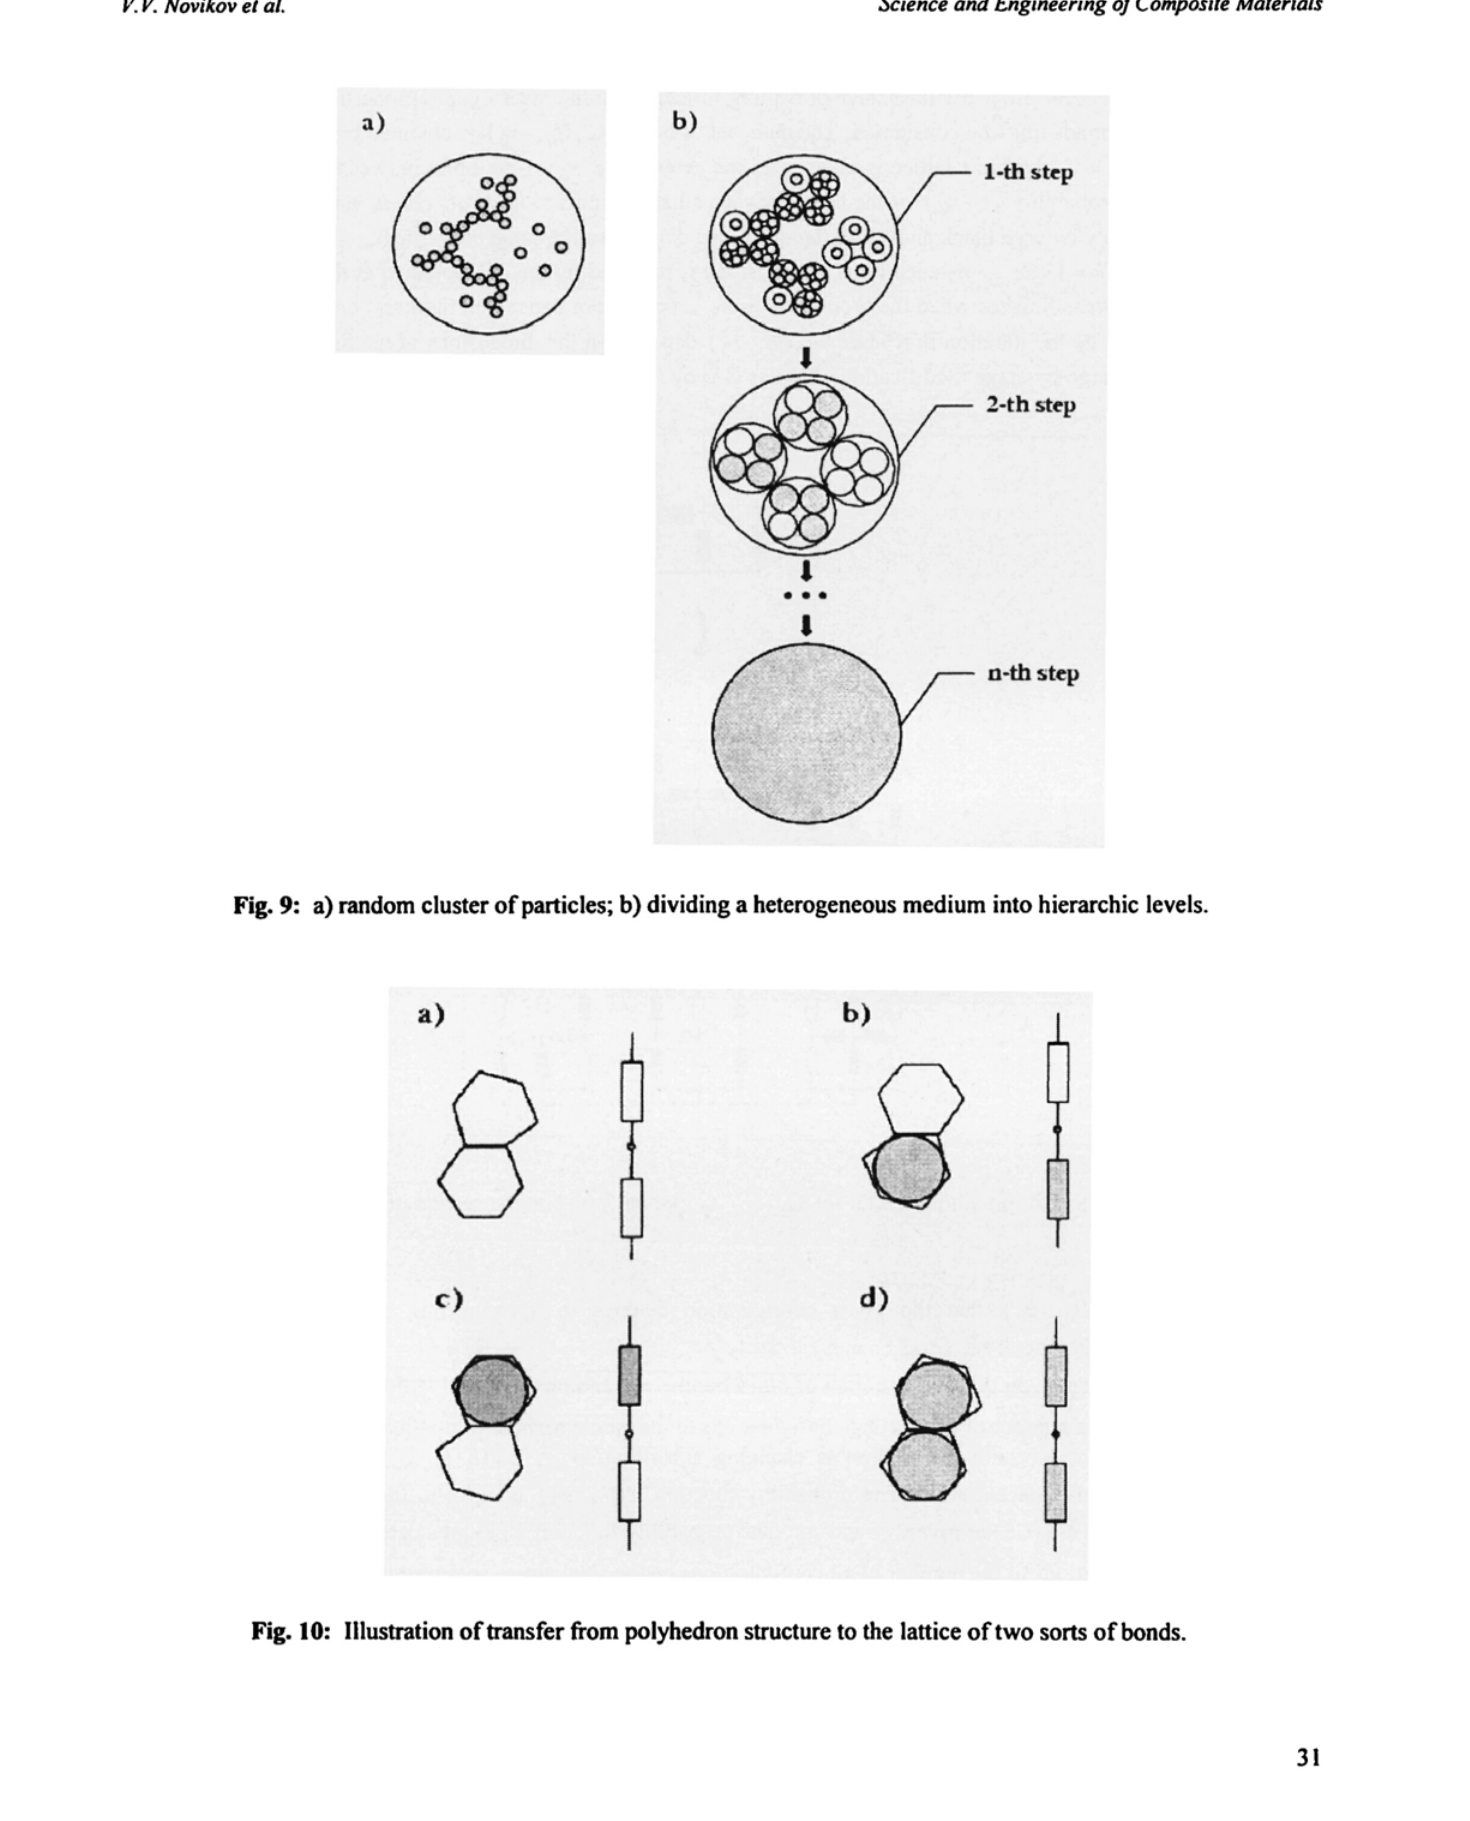
Fig. 10: Illustration of transfer from polyhedron structure to the lattice of two sorts of